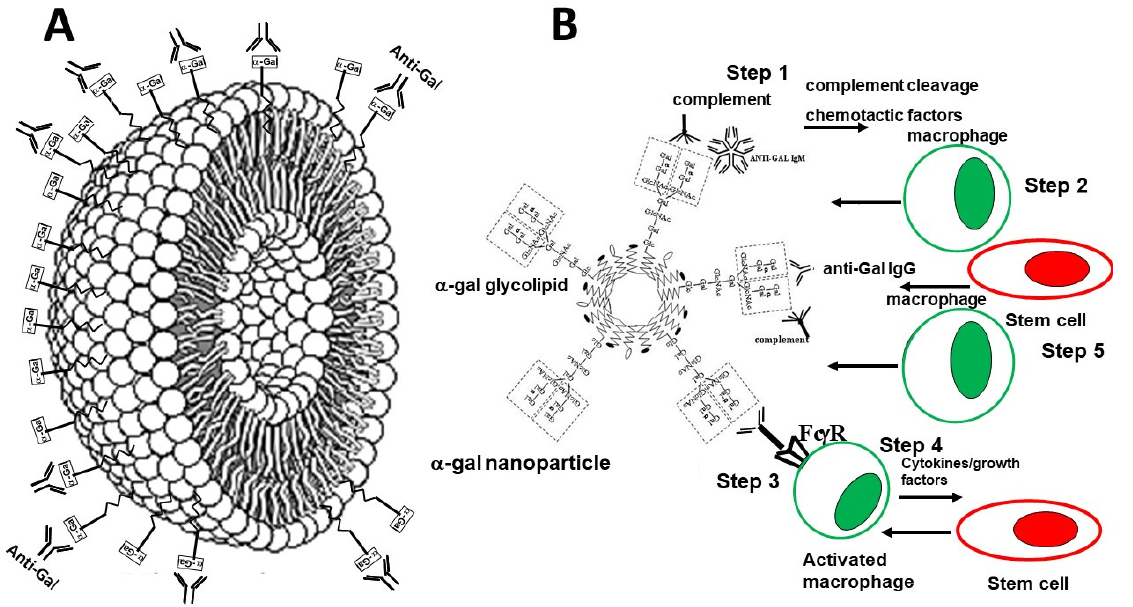
Figure 1. Illustration of the α -gal nanoparticle as a spheric lipid bilayer studded with α -gal glycolipids ( α -gal epitopes illustrated as rectangles on glycolipid molecules) ( A ) and of the hypothesized outcomes of anti-Gal binding to α -gal epitopes on the nanoparticles ( B ). The various steps, following anti-Gal/ α -gal nanoparticles interaction, are detailed below. Macrophages are colored green and stem cells-red. Modified from ref. [57].